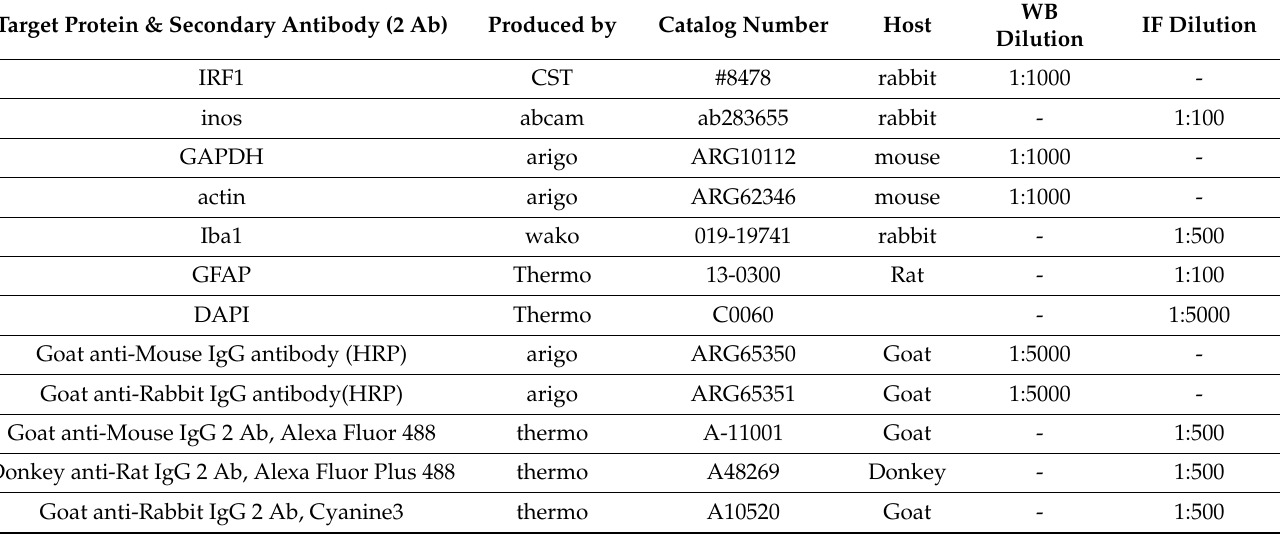
Table 1. Antibody